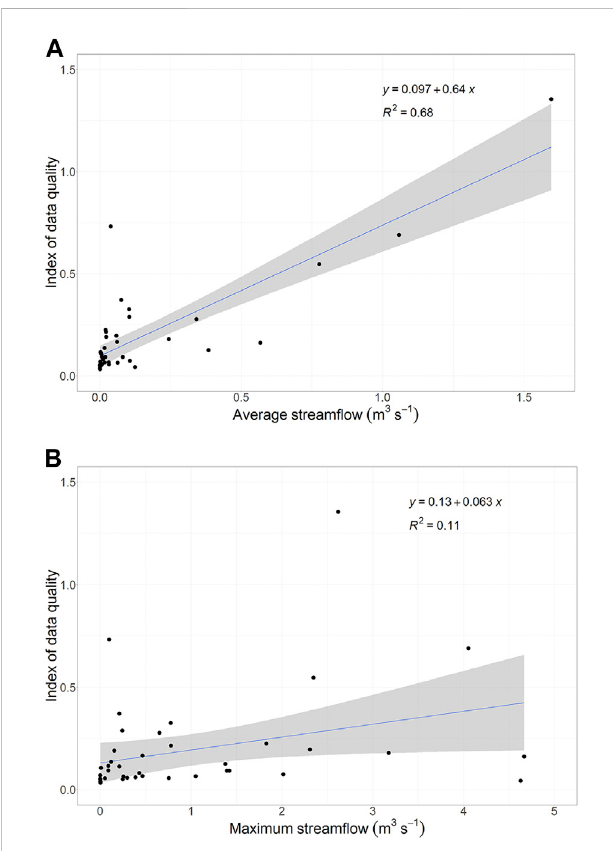
FIGURE 3 The relationship between the index of data integrity and the size of astate ’ ssprings,asmeasuredbyaveragedischarge (A) andthemaximum dischargefor the state (B) . The index of data integrity wascalculated as a functionofthenumberofyearssinceeachspringwaslastsampled, the number of years that it was sampled, and the number of times that it wassampledwithinthattimespan.Greyshadingrepresentsthestandard